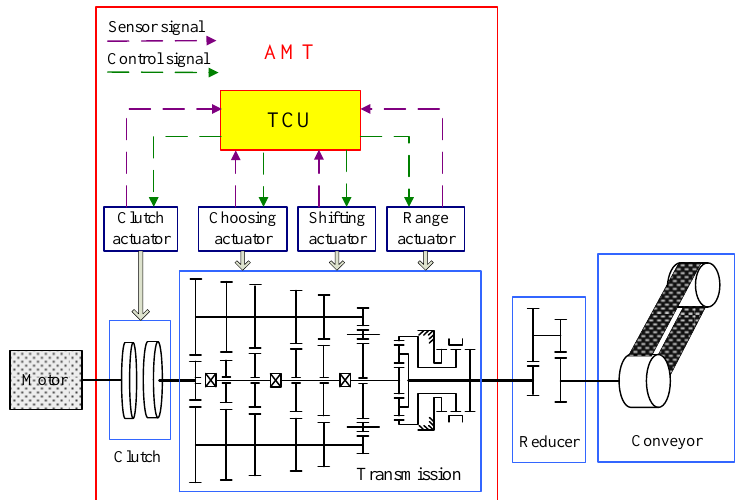
Figure 3. Soft-starting driving system.